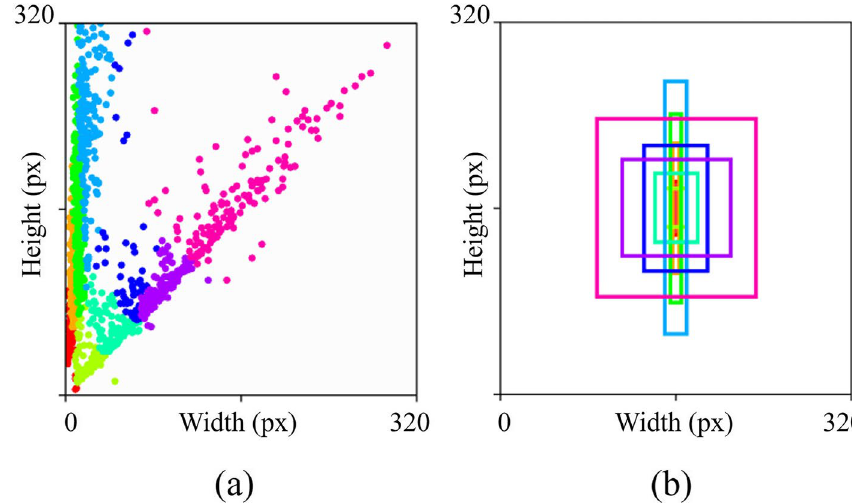
Fig. 3 a Nine clusters (k 9) corresponding to the training set, and b Recalculated anchor boxes for the in-house =